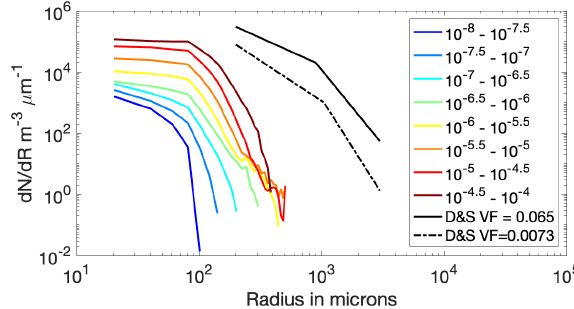
Figure 10. Average bubble size distributions (number of bubbles per micrometre radius increment per unit volume, d N / d R (m − 3 , µm − 1 )) in each void fraction category across the whole data set (coloured lines), compared with the bubble size distributions ob- served by Deane and Stokes for void fractions of 0.065 and 0.0073 in the first few seconds after a wave breaks (black solid and dashed